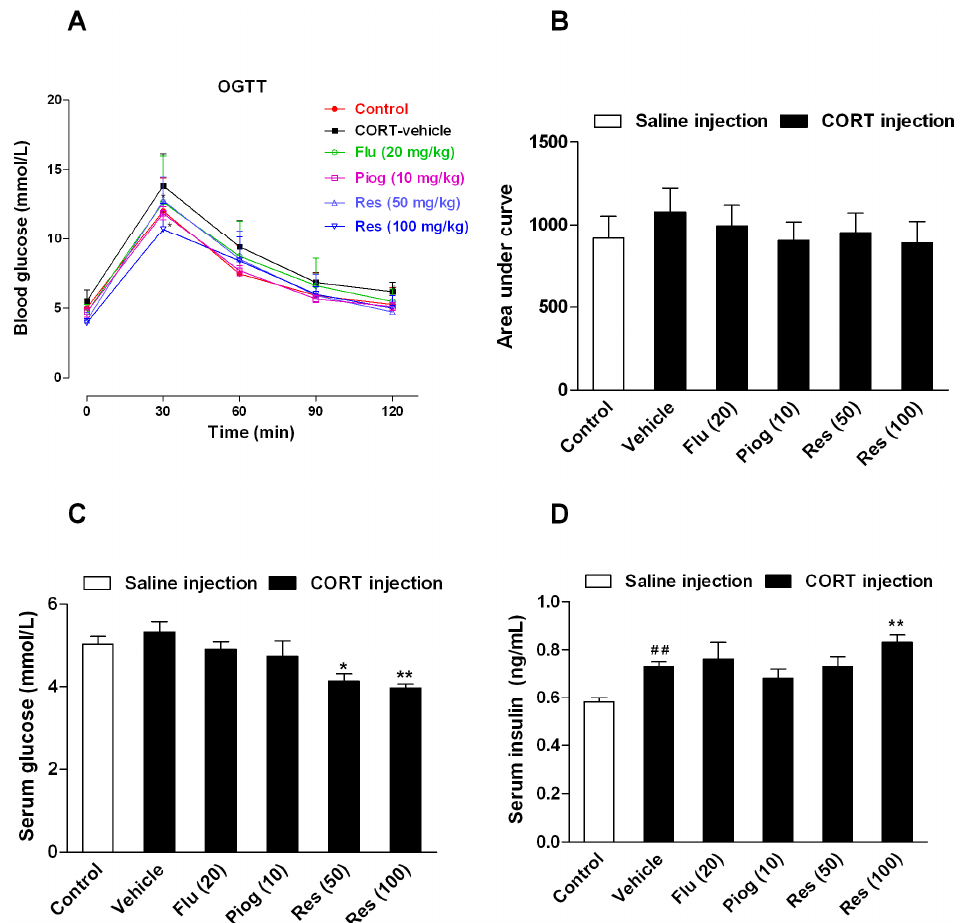
Figure 4. Effects of resveratrol on the insulin sensitivity in CORT-treated mice. ( A ) The curve of blood glucose level during OGTT; ( B ) The area under curve during OGTT; ( C ) The fasting serum glucose level; ( D ) The fasting serum insulin level. Data were expressed as the mean ± S.E.M. ( n = 10). ## p < 0.01 vs . control group. * p < 0.05, and ** p < 0.01 vs . CORT-vehicle group. Data of OGTT was analyzed by two-way repeated-ANOVA with time as the repeat factor. The data of AUC, glucose and insulin were analyzed by one-way ANOVA followed by Dunnett ′ s post hoc test.